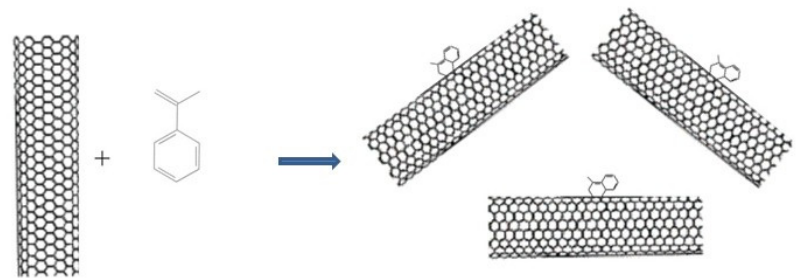
Figure 1. Scheme of joining α -methylstyrene to nanotubes.